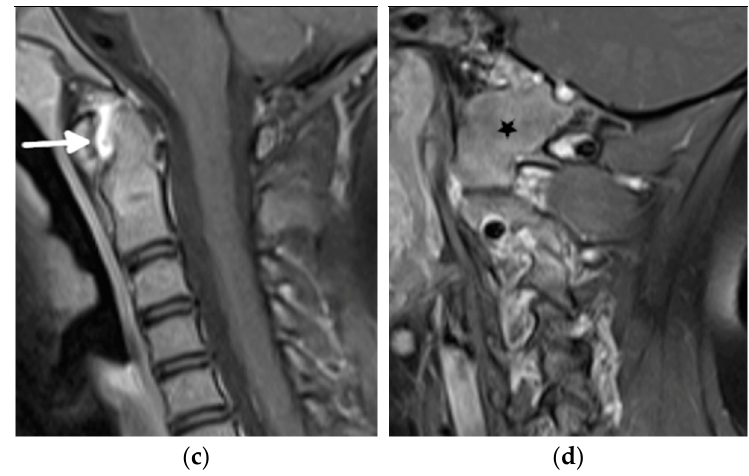
Figure 6. An 11-year-old old girl with juvenile idiopathic arthritis and cervical spine arthritis. Sagittal T1- ( a ), fat-saturated T2- ( b ), and postcontrast fat-saturated T1-weighted show prominent C1/2 joint arthritis with atlantodental joint fluid and synovial enhancement (arrows). Follow-up MRI with postcontrast fat-saturated T1-weighted sagittal MR image ( c ) 2 years later shows ankylosis of the atlanto-occipital joint, still with bone marrow edema consistent with ongoing active inflammation/osteitis (star) ( d ).